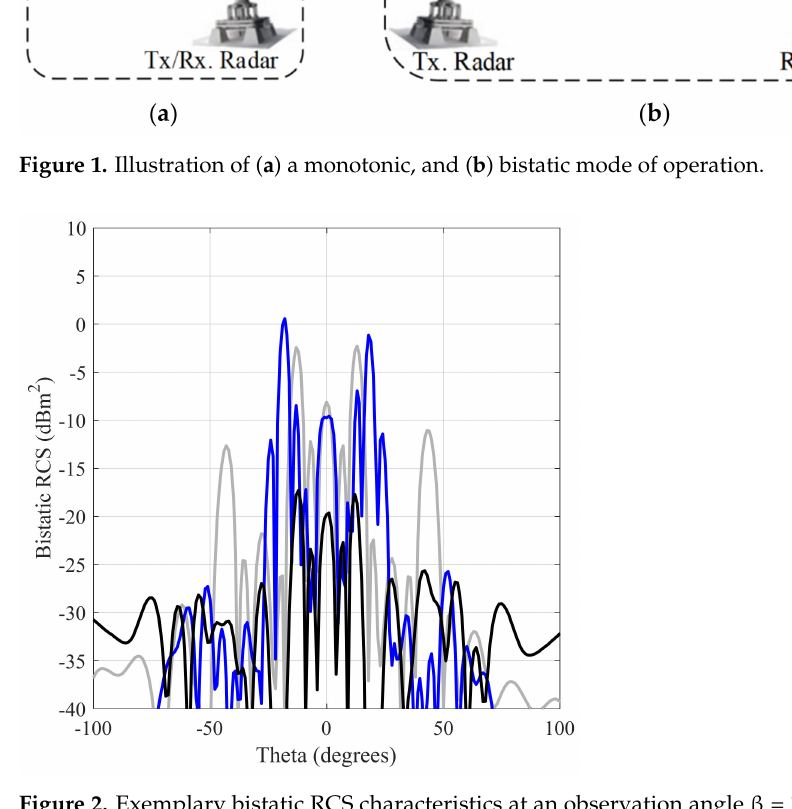
Figure 2. Exemplary bistatic RCS characteristics at an observation angle β = 10 ◦ (gray), 35 ◦ (blue) and 75 ◦